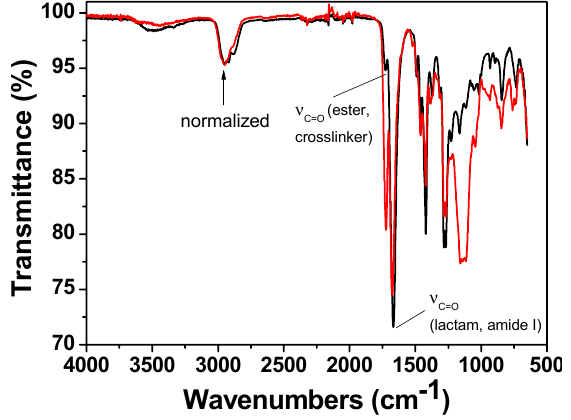
Figure 2. FTIR spectra of the dried membranes M1 (black line) and M2 (red line).